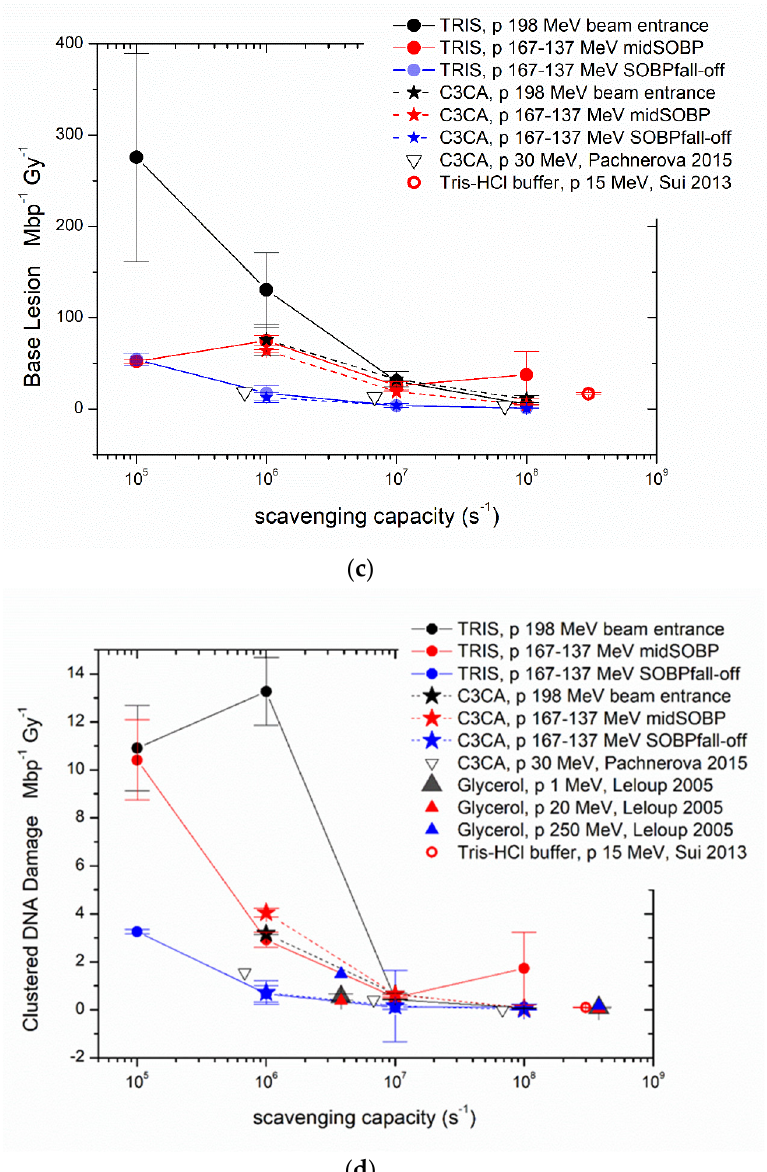
Figure 5. Proton (p) − induced damage yield (Mbp -1 Gy -1 ) versus scavenging capacity (s − 1 ) as calculated in the present study for Tris and C3CA (lines are used as guides to the eyes) and literature values from studies using plasmid models with comparable proton energies and solution scavenging capacity. ( a ) SSB, ( b ) DSB, ( c ) Base Lesion, ( d ) Clustered DNA damage induction rates result from